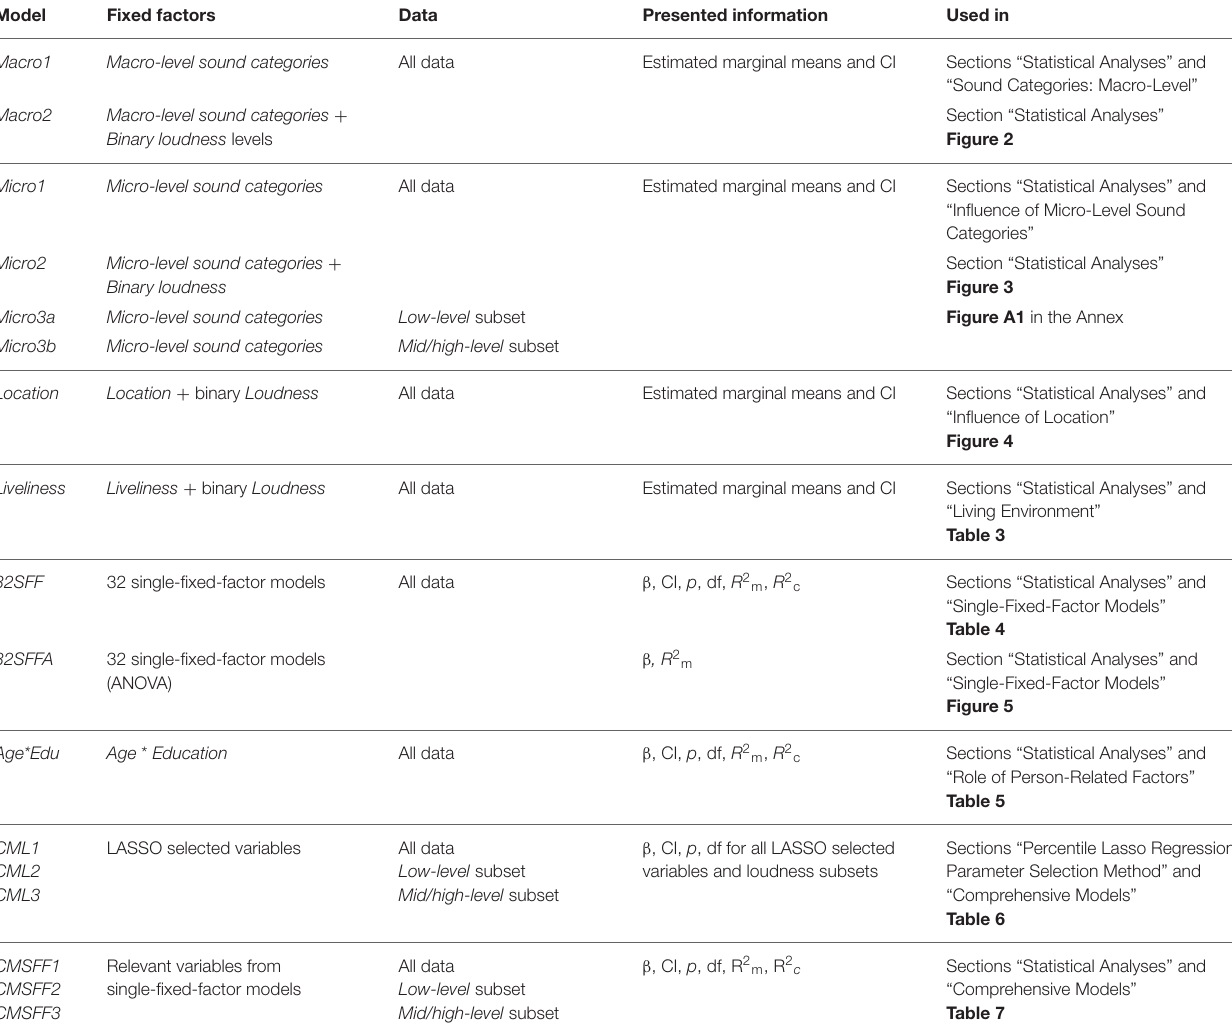
TABLE 2 | Overview about the Models used in this